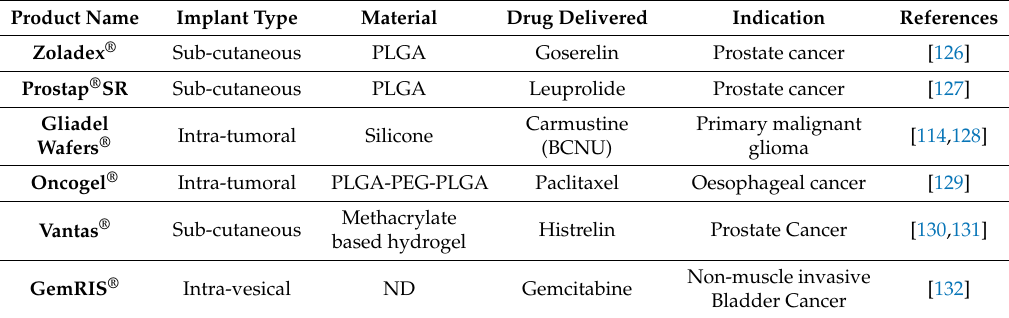
Table 2. Examples of implantable drug delivery devices used for anticancer therapy. ND = not